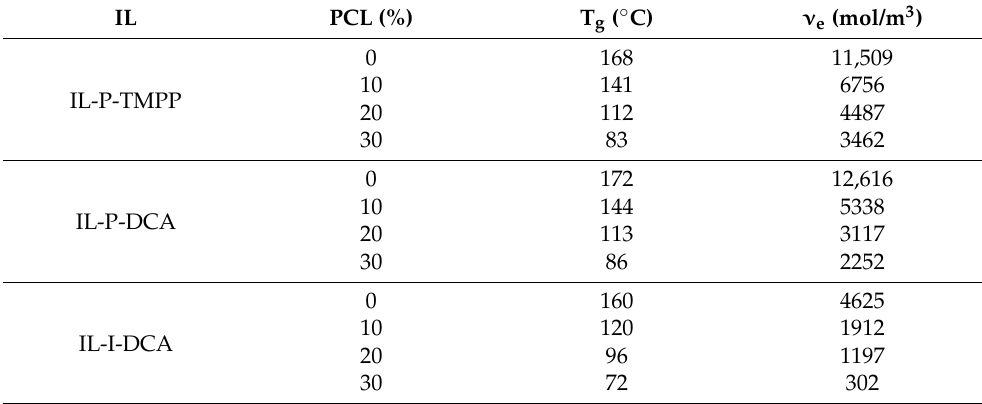
Table 4. T g and crosslinking densities obtained from the DMA analysis.